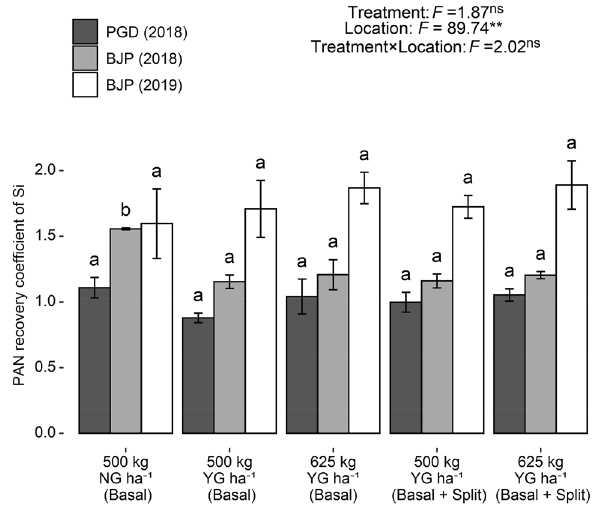
Figure 5. Plant available nutrient (PAN) recovery coefficient of Si in groundnut under different YG treatments. F value and significance level (** P < 0.01, * P < 0.05 and ns P ≥ 0.05). Values followed by a different letter within the same location are significantly different at P < 0.05 probability level. Capped bars at the surface of vertical bars represent the standard deviation, n = 3. YG yellow gypsum, NG natural gypsum, PGD Pavagada, BJP Baljigapade.